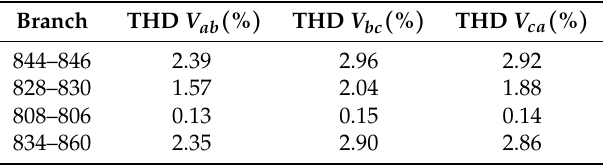
Table 7. THD of Phase to Phase Voltages in Low EV Penetration.